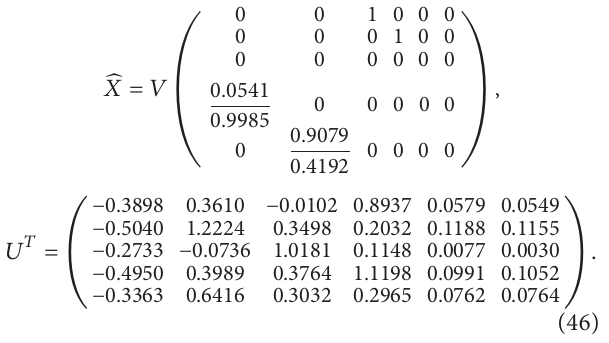
1023 𝑝=0 , where 𝑝 = 0, 1, . . . ,